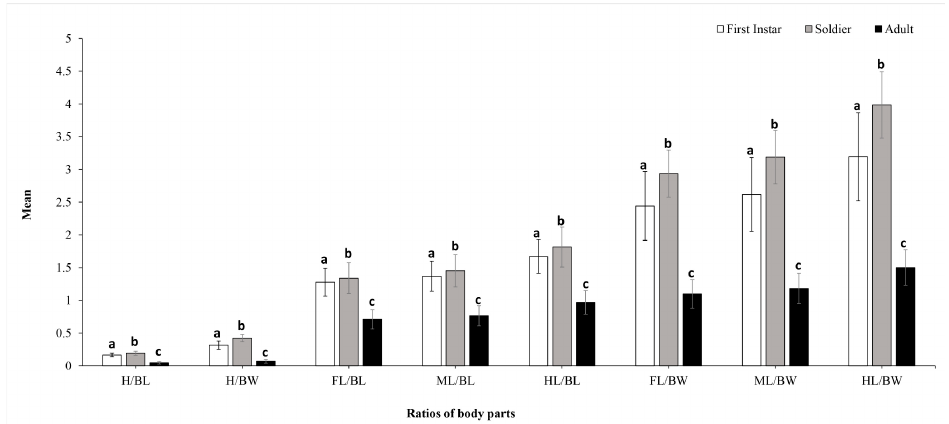
Figure 2. The comparison of body part ratios of different morphs of P. bambucicola . Letters on bars mean significant differences ( p < 0.001).